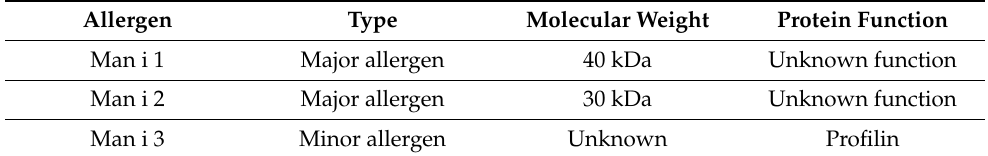
Table 1. Mango allergens profile. Allergen Type Molecular Weight Protein Function Man i 1 Major allergen 40 kDa Unknown function Man i 2 Major allergen 30 kDa Unknown function Man i 3 Minor allergen Unknown